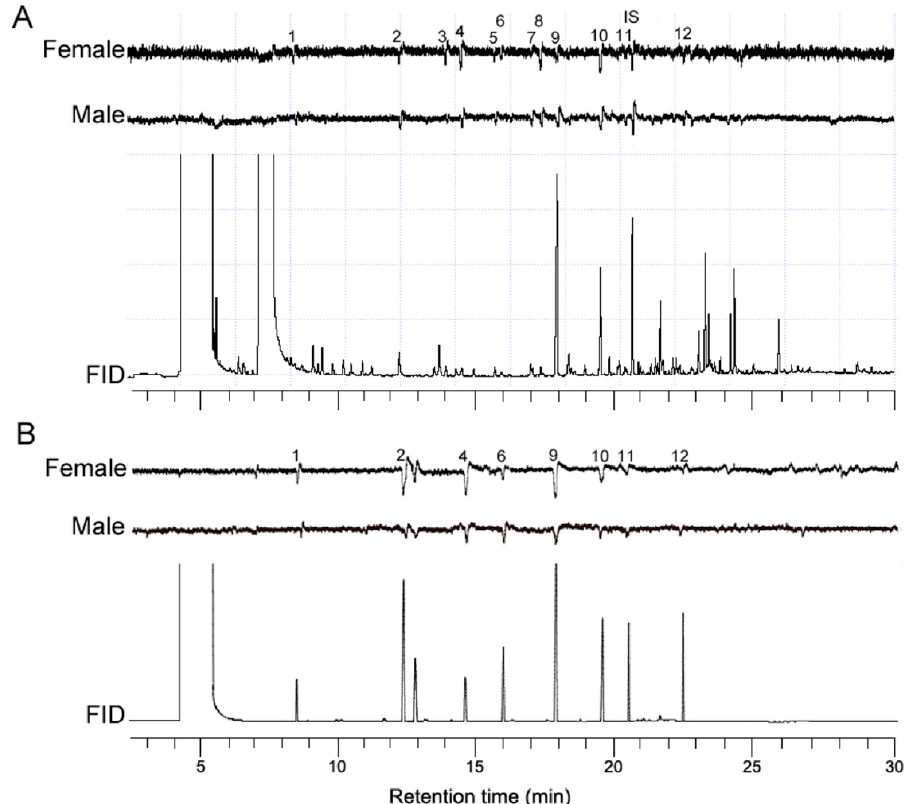
Figure 1. Simultaneous responses of flame ionization detector (FID) and of H. parallela antenna (electroantennographic detection, EAD). The upper traces in each figure represent the signals from the EAD and the lower trace represents the signal from the FID. ( A ) Headspace volatile sample collected from the peanut plants. ( B ) Mixture of synthetic compounds. The upper trace in each figure represents the signal from the EAD and the lower traces represent the signals from the FID. 1, hexanal (8.35; 3.04%) *; 2, ( Z )- β -ocimene (12.31; 2.54%); 3, unidentified (13.69; 7.50%); 4, 6-methyl-5-hepten-2-one (14.38; 5.80%); 5, unidentified (15.45; 7.89%); 6, nonanal (15.76; 5.47%); 7, unidentified (16.75; 9.74%); 8, unidentified (17.12; 6.06%); 9, dihydromyrcenol (17.76; 29.20%); 10, linalool (19.46; 12.15%); 11, β -caryophyllene (20.40; 5.46%); 12, methyl salicylate (22.48; 5.14%); IS, methyl benzoate. * Retention time and relative percentage of the EAD active